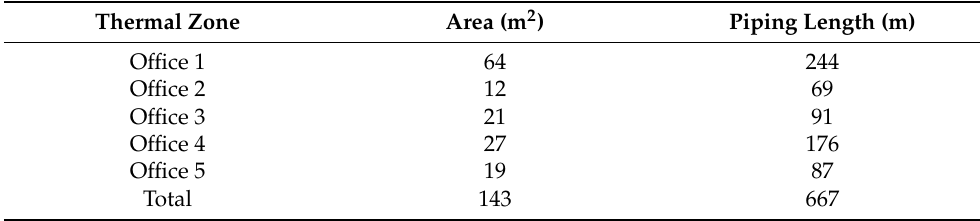
Table 3. Floor area and piping length of the offices with hydronic radiant system. Thermal Zone Area (m 2 )